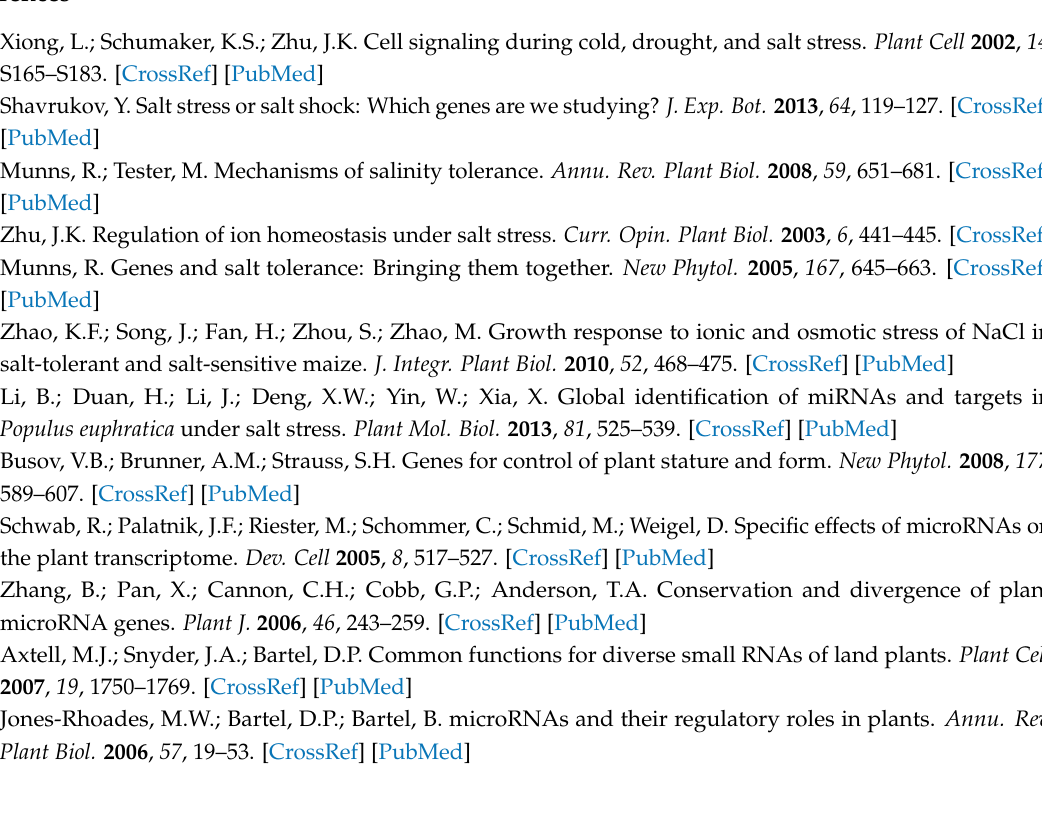
Table S1: Primer pairs used in real-time quantitative RT-PCR, Figure S1: Distribution of small RNAs among different categories in three libraries, Figure S2: Mature and the predicted fold-back structures of newly identified miRNAs in cotton. Sequences of mature miRNAs are underlined, Figure S3: Dissociation Curve of seven miRNAs for Real-time quantitative PCR, Figure S4: Target sites in ARF2 , ARF3 and ARF4 genes of G. arboreum and G. raimondii . Target site was shown as straight